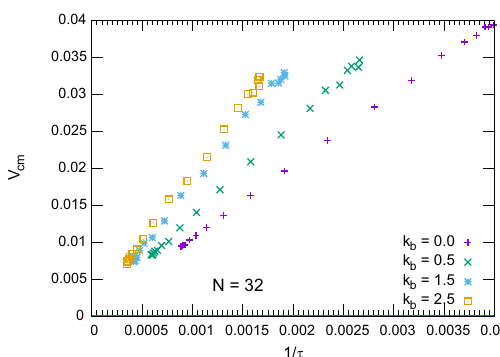
Figure 5. Velocity as a function of the 1/ τ . The linearity of the curves indicates that the relation τ ≈ v 1/ holds for a large range of forces here